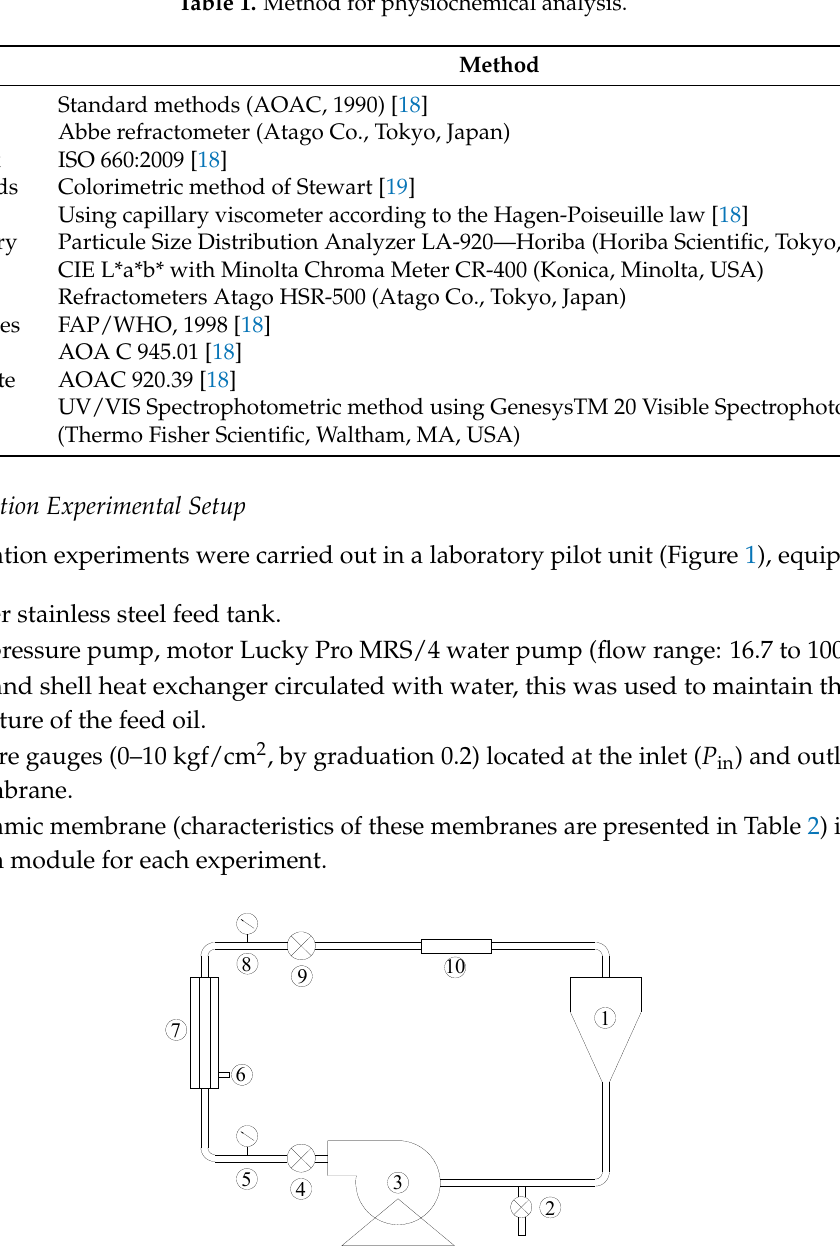
Figure 1. Filtration pilot (1—Feed tank; 2—Feed removing valve; 3—Feed pump; 4—Inlet valve; 5—